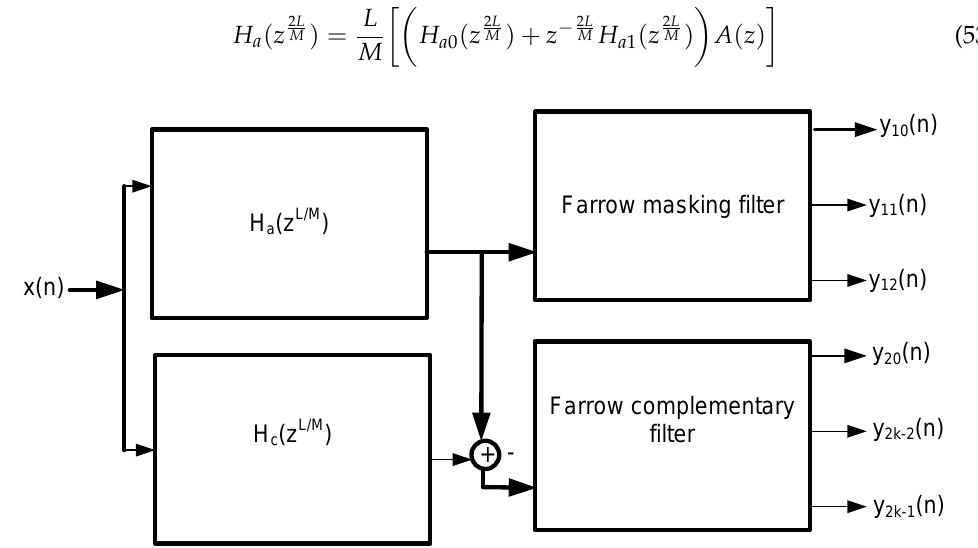
Figure 3. Block diagram of coefficient decimated FRM Farrow-based FIR